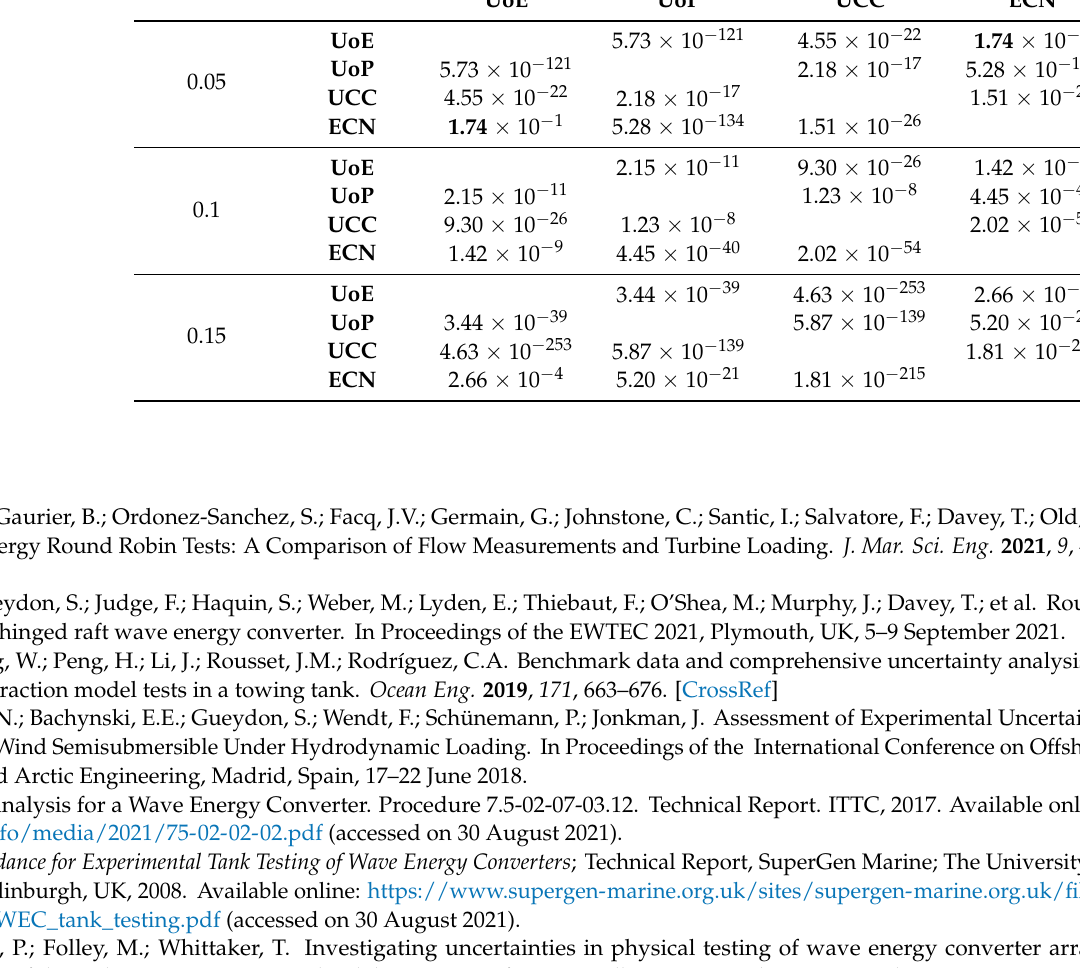
Table A5. Mann–Whitney U test p -values, T p = 2.05 s. Values greater than 0.05 marked in bold. H s